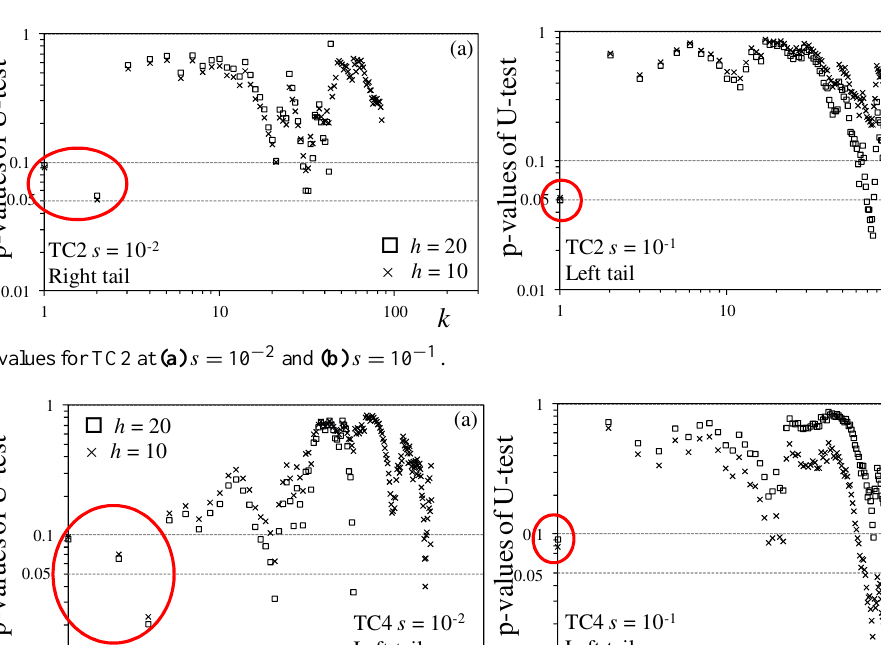
Fig. 6. U test p values for TC1 at (a) s = 10 − 2 and (b) s = 10 − 1 .